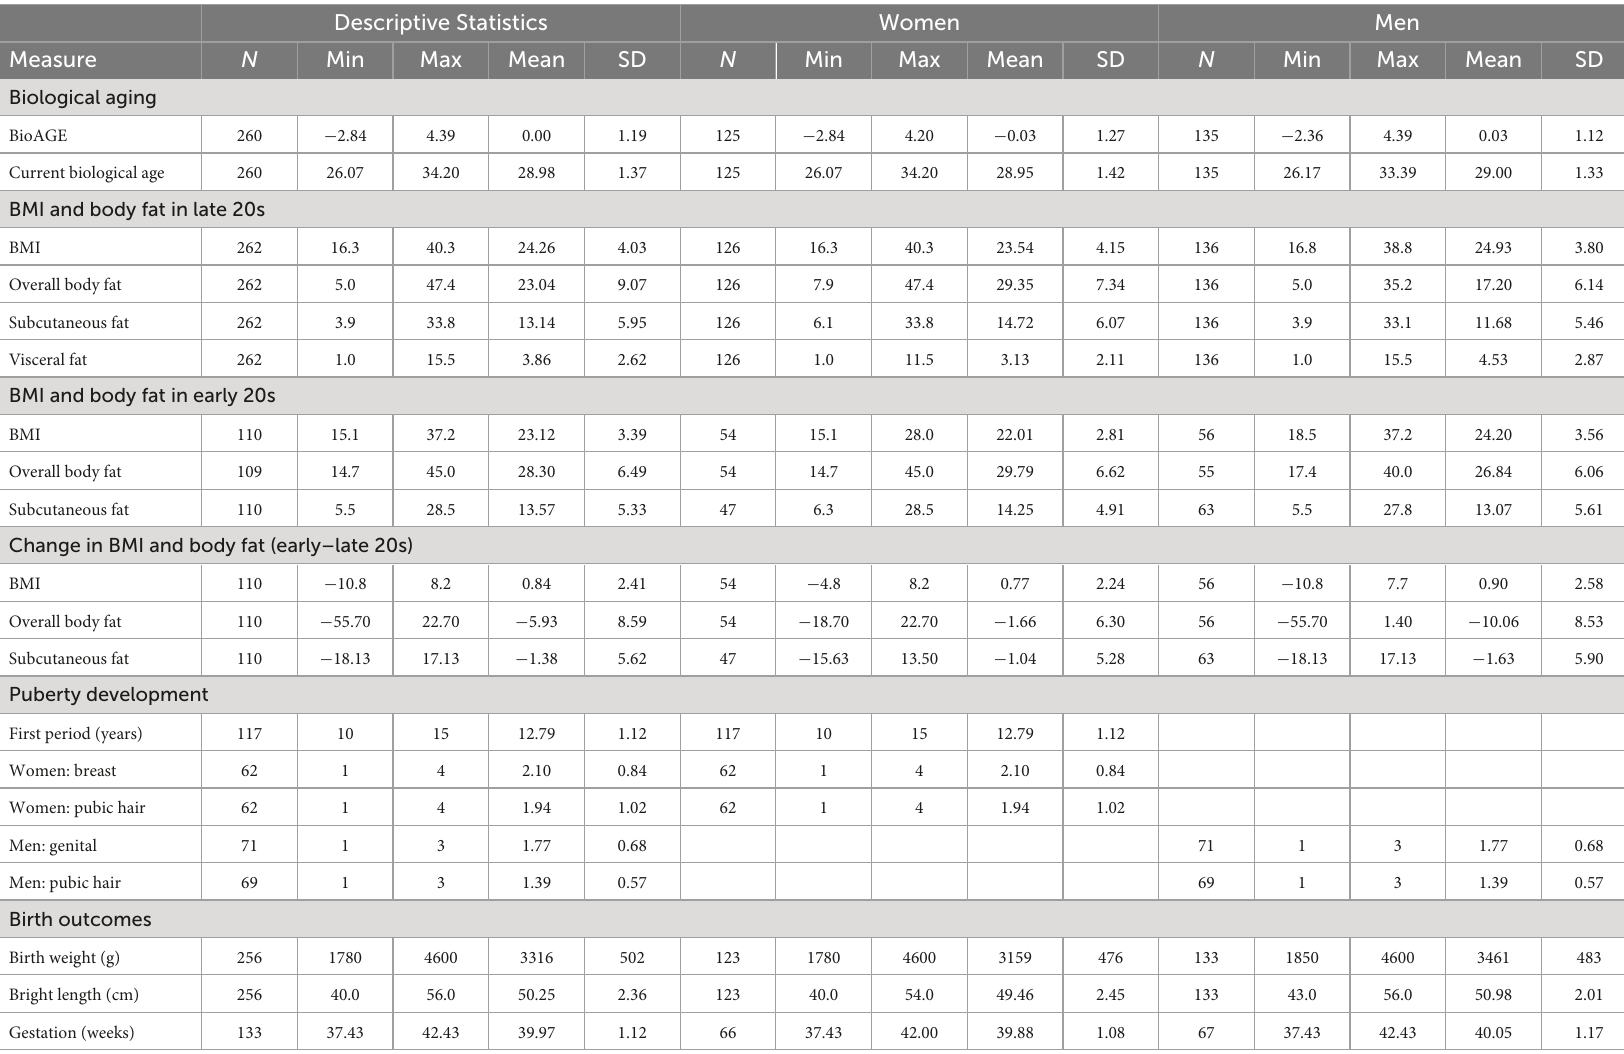
TABLE 2 Biological aging and its predictors–descriptive